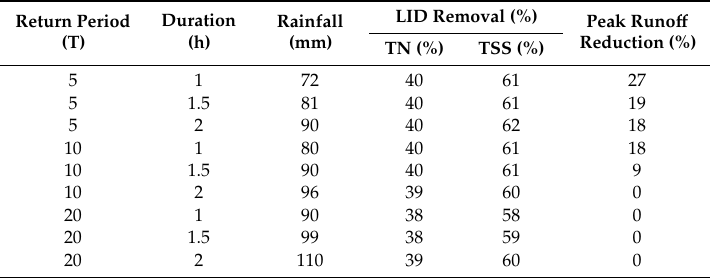
Table 6. Results of model performance for the selected rainfall